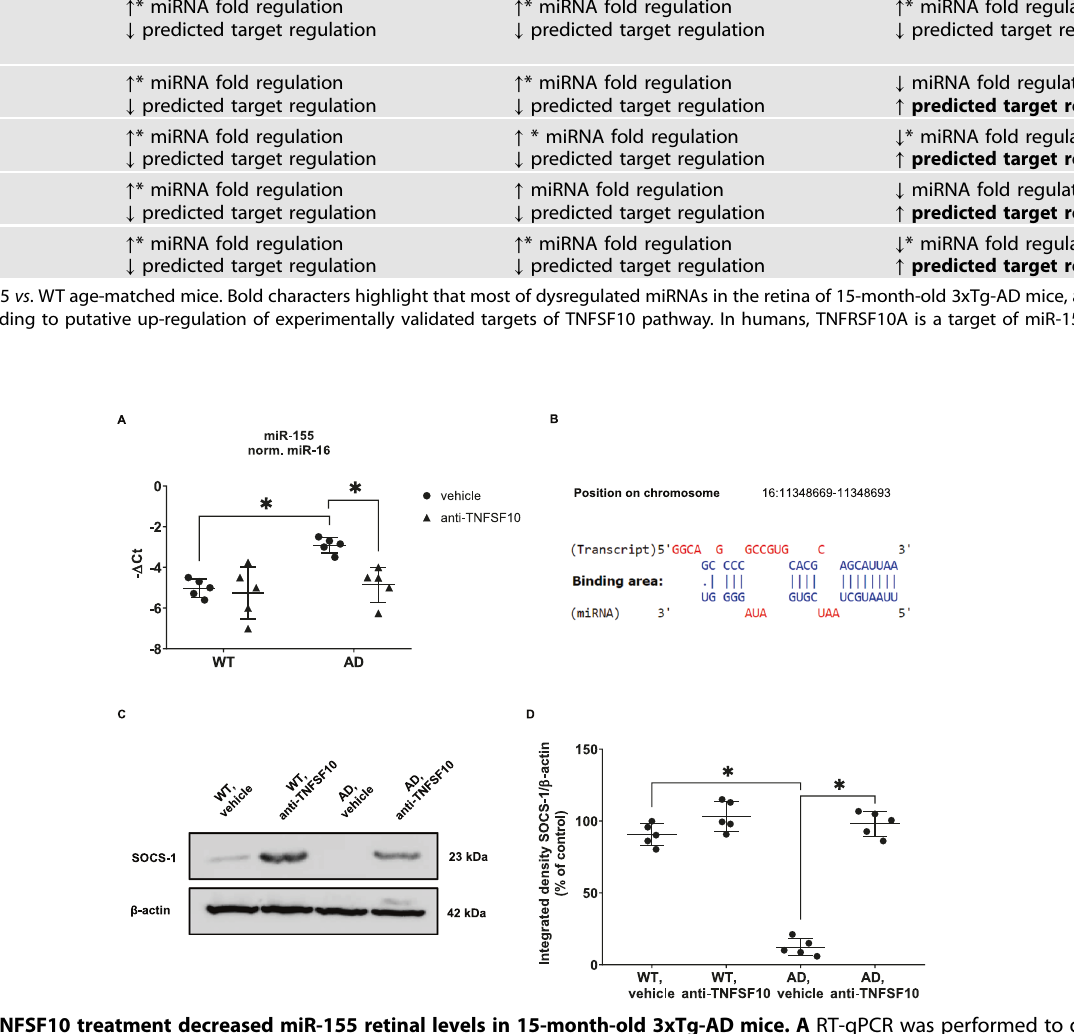
Fig. 3 Anti-TNFSF10 treatment decreased miR-155 retinal levels in 15-month-old 3xTg-AD mice. A RT-qPCR was performed to determine the retinal expression of miR-155-5p in 15-month-old 3xTg-AD mice treated with anti-TNFSF10. One-way ANOVA and post-hoc Tukey ’ s multiple comparisons test were used. N = 5 animals; 5 independent retinal samples, 2 pooled retinas per sample in each group. B Bioinformatic prediction of SOCS-1 mRNA binding with miR-155-5p. C Western blot analysis was performed to evaluate the expression of the miR-155-5p molecular target SOCS-1 in the retinas of 3xTg-AD mice. D Densitometric analysis of western blots. Data are expressed as mean ± standard deviation. One-way ANOVA and post-hoc Tukey ’ s multiple comparisons test were used to determine statistical signi fi cance. * p < 0.05. N = 5 animals; 5 independent retinal samples, 2 pooled retinas per sample in each